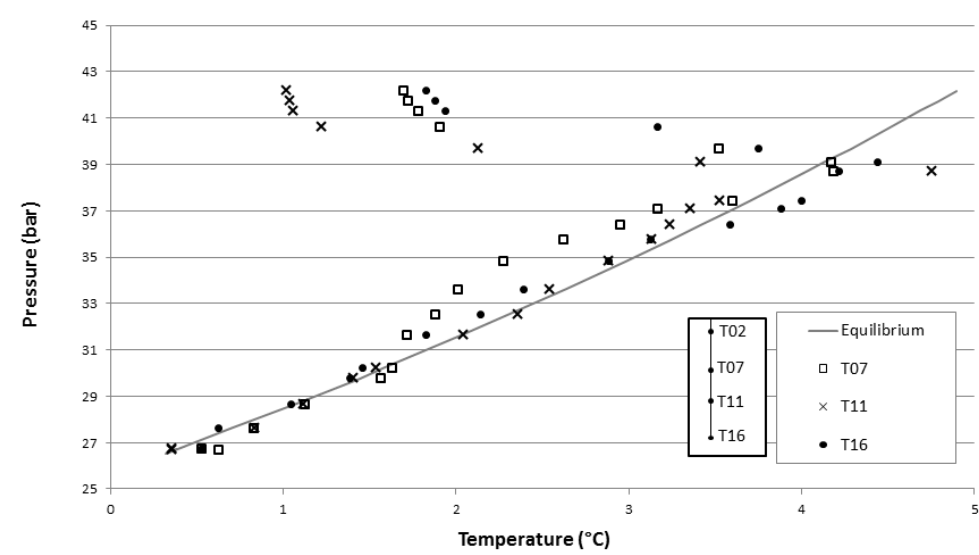
Figure 8. P-T graph, comparison between experimental conditions and theoretical equilibrium profile.